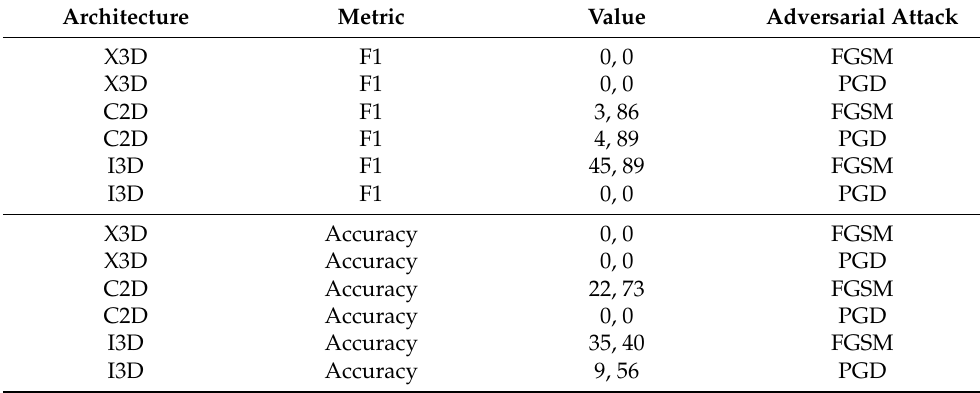
Table 2. Video-level results. The column metric means which one was used to compute the result and the adversarial attack column means which method was used to compute the attack. Each row represents an experimentation scenario.